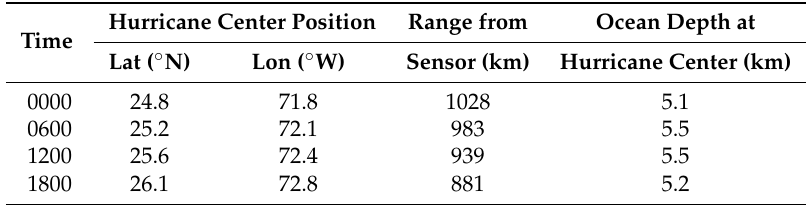
Table 1. Parameters for Hurricane Bonnie on 24 August